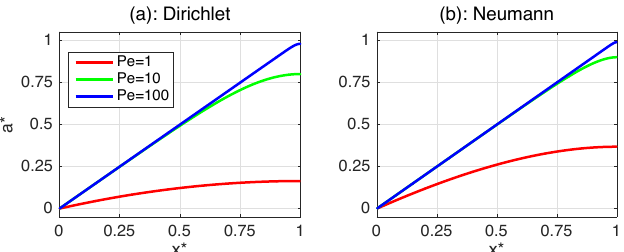
Figure 6. Illustration of the ages obtained from the solution of the one-dimensional problem outlined in Figure 4. Panel ( a ) depicts the age ensuing from Dirichlet boundary conditions imposed at the departure boundary ( x = L ) and, hence, is the same age as that represented in panel ( c ) of Figure 5. The age obtained by prescribing Neumann boundary conditions at x = L , that is, age (52), is illustrated in panel ( b ). Dimensionless variables are represented. They are identified by asterisks and are defined as follows: x ∗ = x / L and a ∗ = aU / L